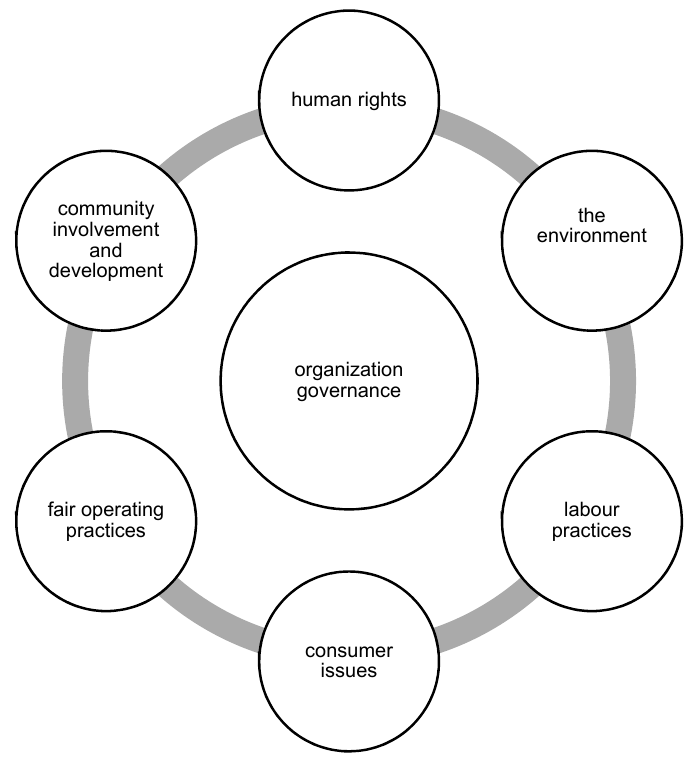
Figure 3. CSR areas according to ISO 26000. Source: own study based on: Polish Standard PN-ISO 26000: 2012 Guidelines on social responsibility in KT 305 for Social Responsibility published on 5 November 2012.